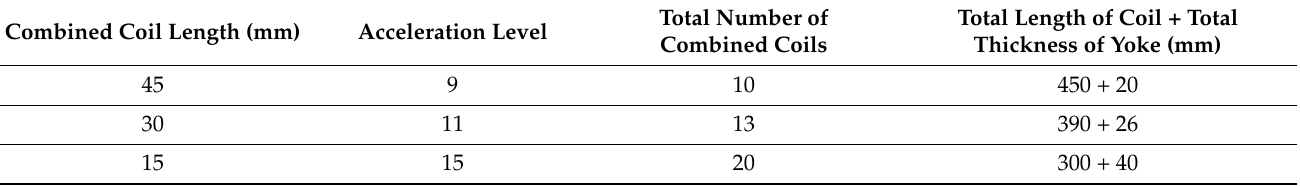
Figure 15. Comparison curve of electromagnetic force of combined coils with different lengths. Table 3. Coil parameters of different combinations.